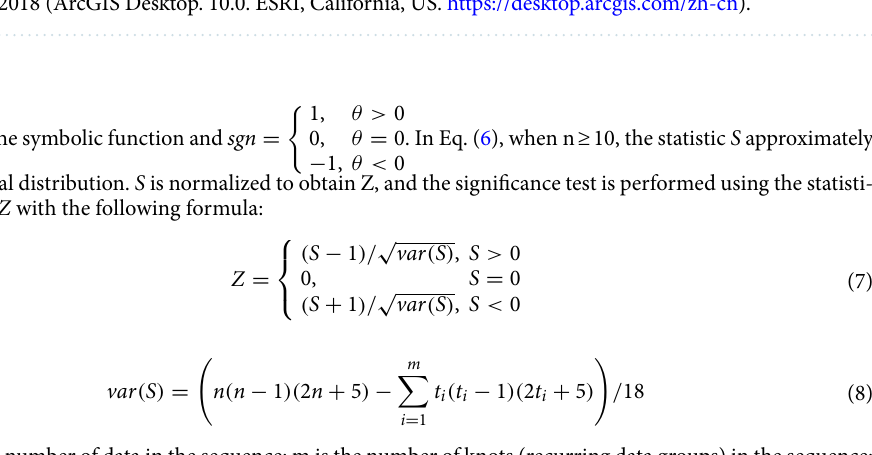
Figure 2. Spatial patterns of annual mean precipitation of ERA5 (right panel) and observation (OBS, left panel) from 1979 to 2018 (ArcGIS Desktop. 10.0. ESRI, California, US. https:// deskt op. arcgis. com/ zh-